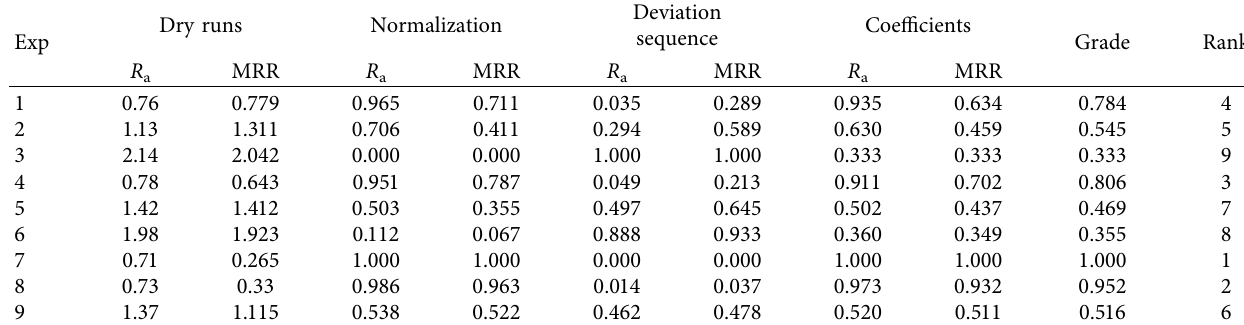
Table 12: Grey regression analysis-MQL.